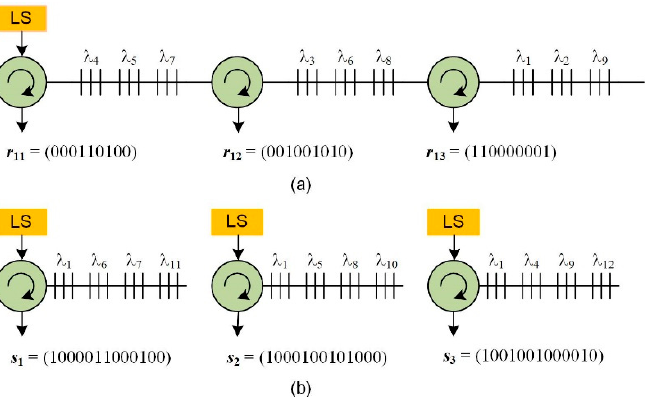
Figure 3. Optical encoder structures based on FBG of ( a ) RSQC and ( b ) SQC codes. LS: light source.